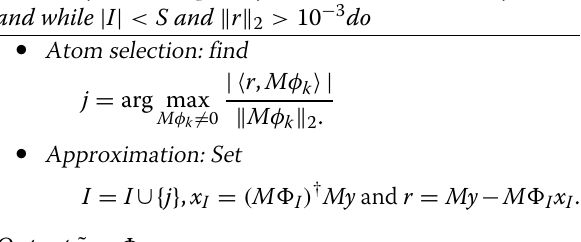
Algorithm 4 (Masked OMP for Inpainting